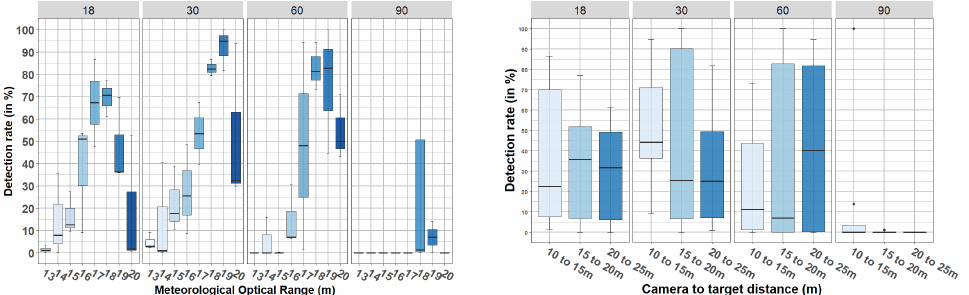
Figure 25. Detection rate (in %) obtained during dynamic scenarios—targets in motion—car